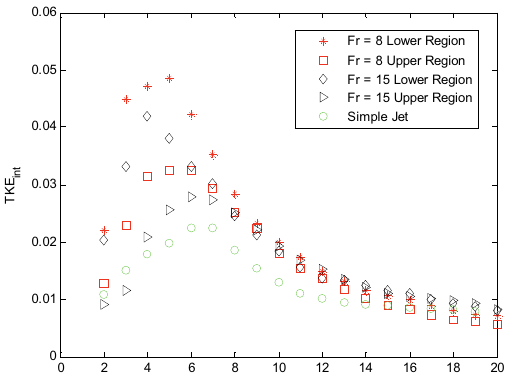
Figure 8. Streamwise decay of the integral non- dimensional Turbulent Kinetic Energy TKE/U max2 in the upper (squares Fr = 8, triangles Fr=15) and lower (asterisks Fr=8, rhombi Fr=15) region of the near-field of an INBJ with Re = 1000, θ = 65° and different Fr and of a simple jet with the same Re (green